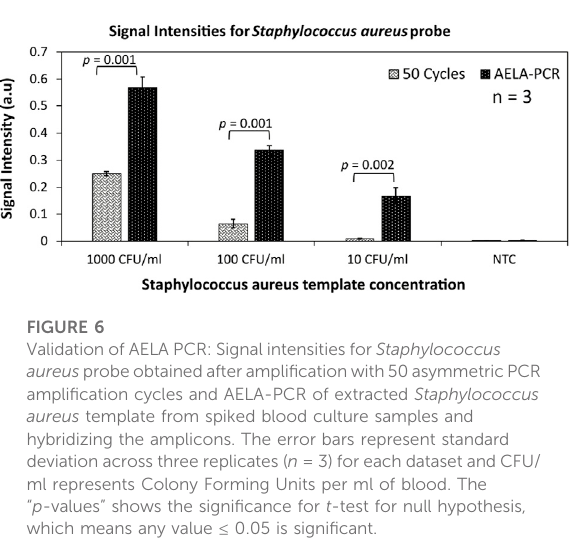
TABLE 3 Signal intensities and standard deviation of Staphylococcus aureus probe at different concentrations (NTC represents No Template